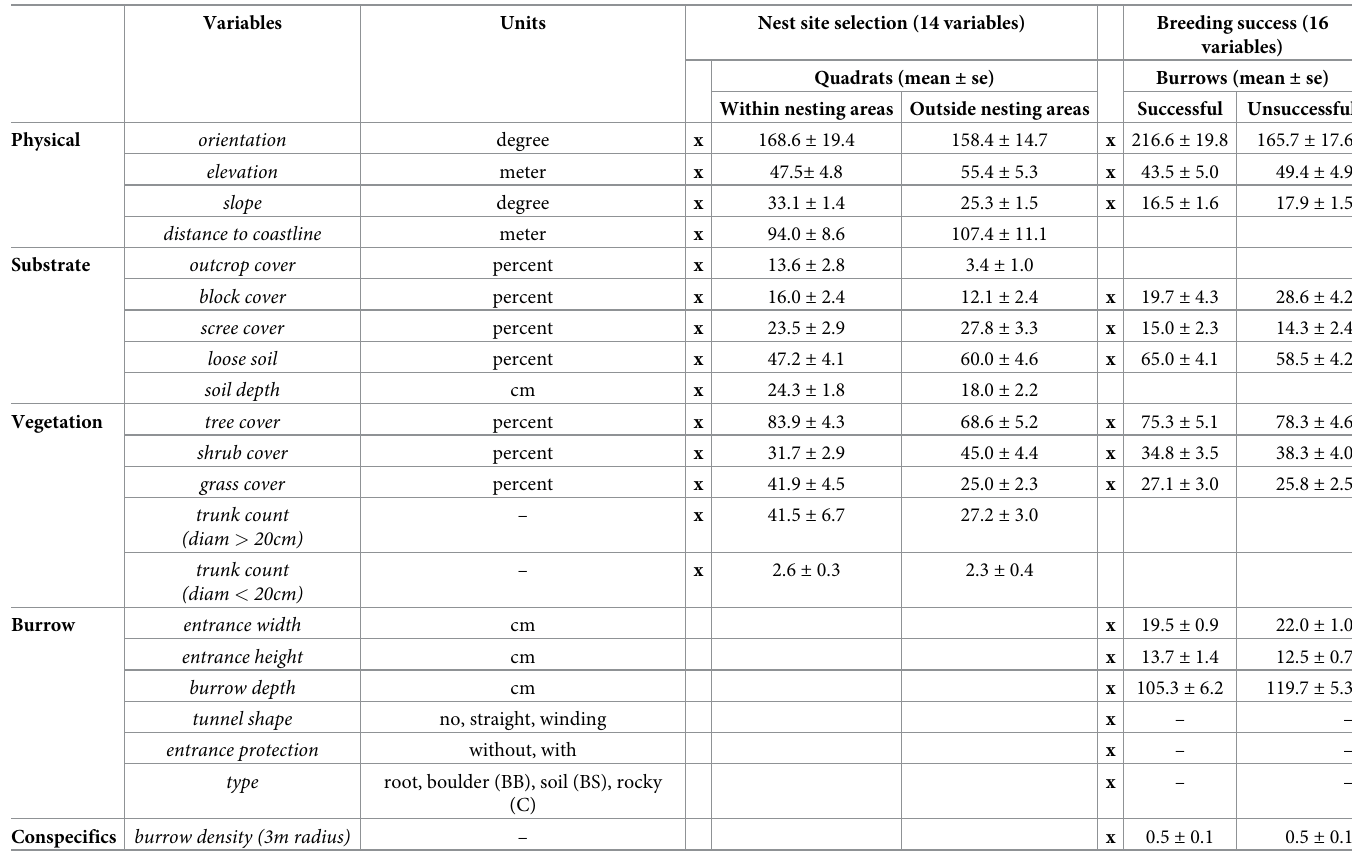
Table 1. Variables measured in 102 quadrats (51 within and 51 outside nesting areas) and around 87 burrows (48 successful and 65